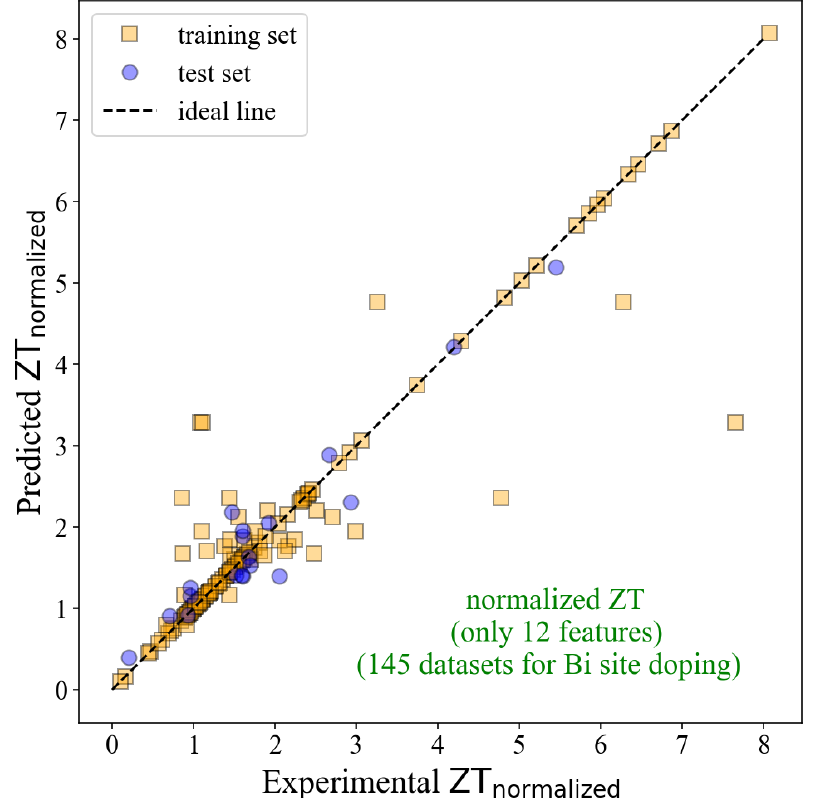
Figure 6. The plot of the Predicted ZT normalized versus the Experimental ZT normalized from the ML model using ET regressor. The total dataset of 145 datasets was used with the first 12 important features, resulting in the R 2 of 0.93 and the RMSE of 0.33.